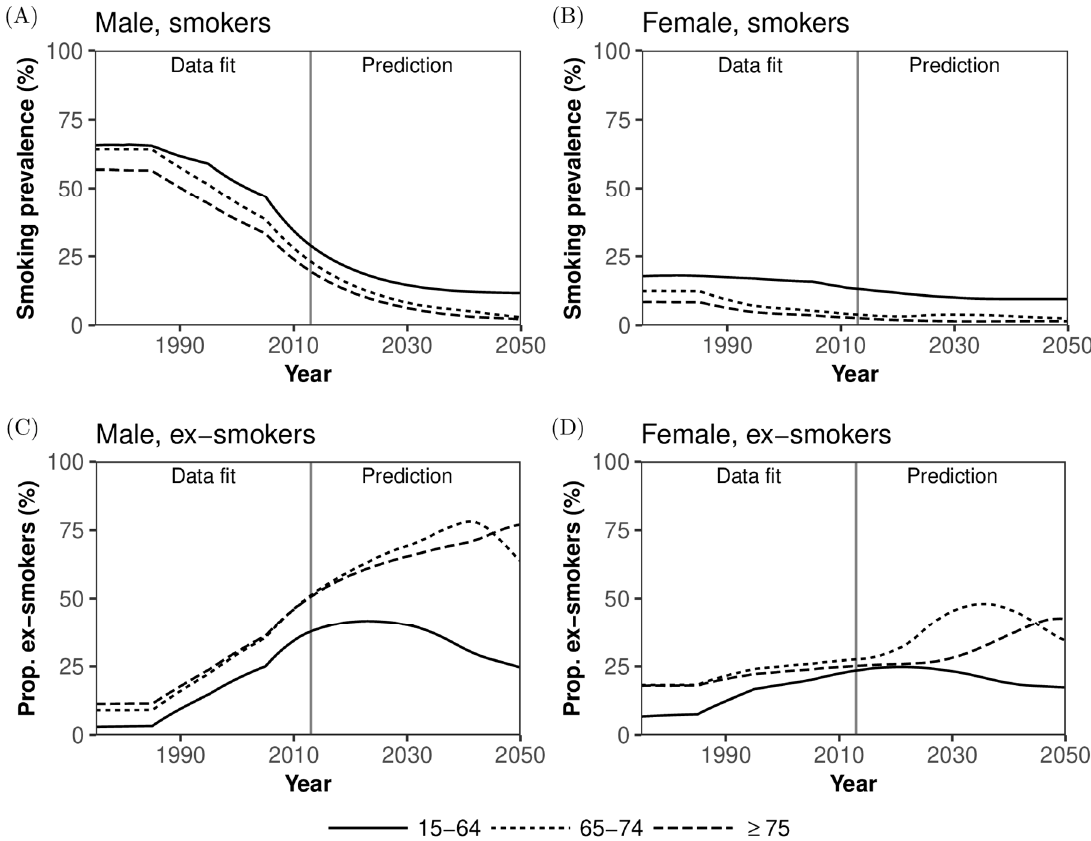
Figure 5. Smoking prevalence in Japan. Comparisons between observed and predicted smoking prevalence in Japan. ( A ) Smoking prevalence in men, ( B ) Smoking prevalence in women, ( C ) Ex-smokers’ prevalence in men, and ( D ) Ex-smokers’ prevalence in women. Solid line represents the estimated prevalence among those aged 15–64 years, dotted line represents the prevalence among those aged 65–74 years, and dashed line shows the estimate among people aged 75 years or older. Lines for 2015 and later indicate predictions calculated using maximum likelihood estimates at the latest time.